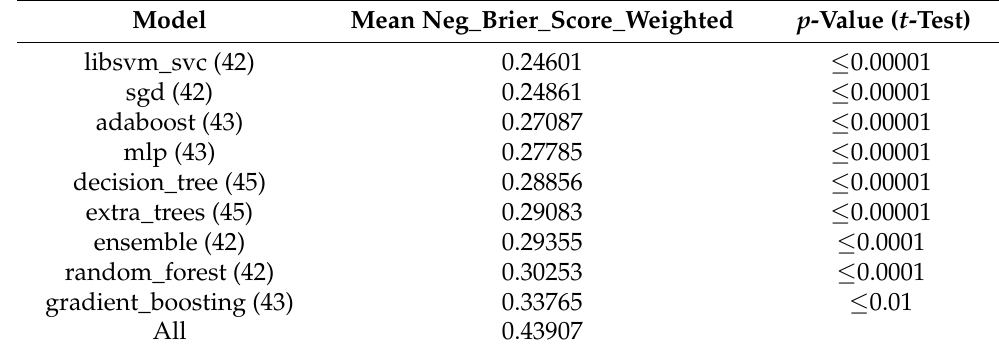
Table A15. Models with significantly better mean Brier score loss weighted.